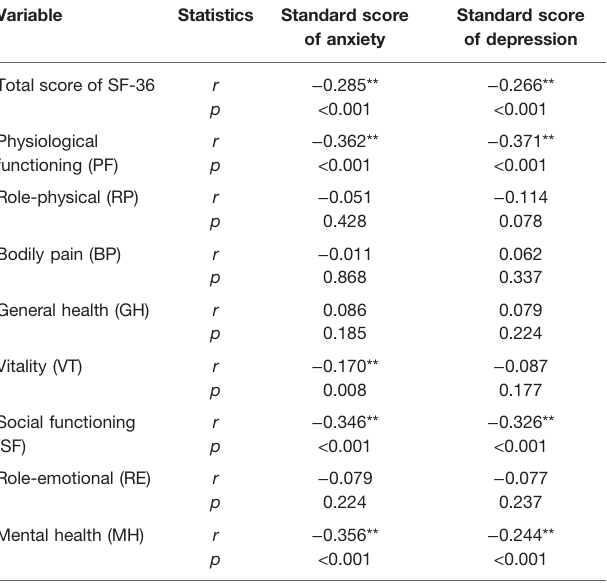
TABLE 4 | Correlation between psychological status and quality of life in discharged patients with hepatolithiasis and diabetes mellitus with T-tube ( n